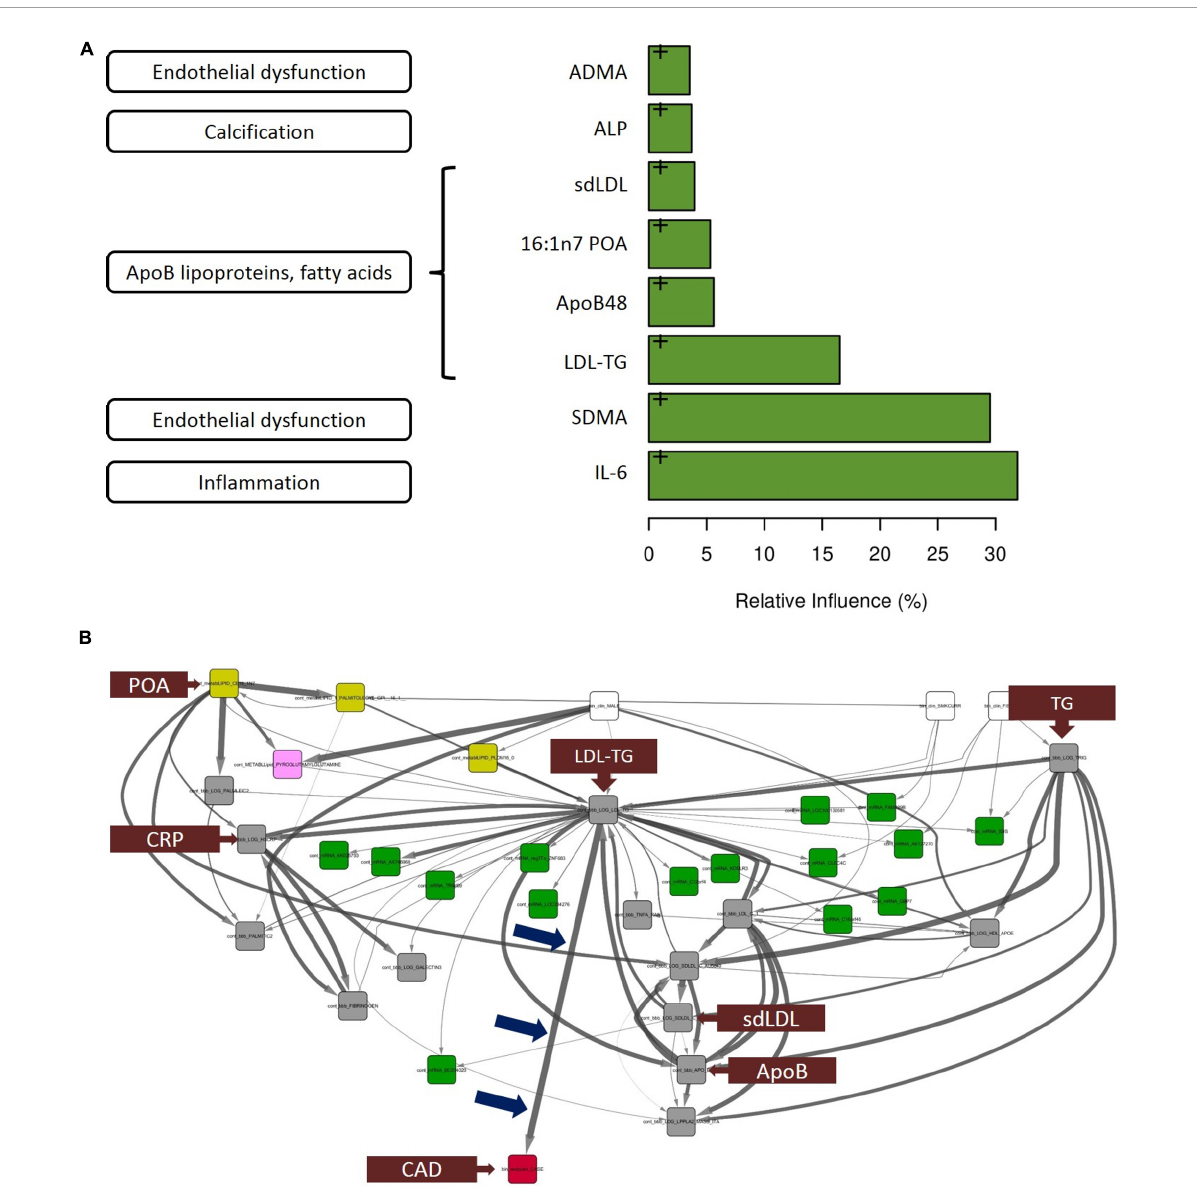
FIGURE2 Gradient boosting analysis identified the strongest predictors of atherosclerotic coronary artery disease. Hypothesis-free Bayesian network analysis using reverse engineering with forward simulation (REFS TM ) Suggests a potential causal role of triglyceride-rich LDL particles, as measured by LDL-TG levels, in the development and progression of atherosclerosis. (A) Out of the 30 conventional biomarkers included in the multivariate analysis, the top 8 analytes are shown in the bar graph. The length of the bar corresponds to the relative influence the biomarker in predicting atherosclerotic coronary artery disease. The biomarkers include IL-6 (inflammation), symmetric dimethylarginine (endothelial dysfunction), and LDL-TG (ApoB-containing lipoprotein cluster). (B) This figure is not an illustration; it is an actual output from the hypothesis-free Bayesian network analysis. A total of 24,929 nodes and 110,350 edges were discovered in more than 5% of the networks in the ensemble; shown is the subnetwork of measurements with 1 degree of separation from LDL-TG. Arrow thickness indicates the fraction of networks in which the causal edge appears; different colored boxes represent different types of measurements (yellow: mass-spectrometry–based lipidomics; pink: mass-spectrometry–based metabolomics; green: gene expression [mRNA]; gray: conventional biomarker measurements). Notably, among all of the biomarkers that were measured and included in the model, LDL-TG was the only biomarker with a direct connection to ASCAD (see blue arrows pointing to the edge connecting LDL-TG to ASCAD). This suggests that triglyceride-rich lipoprotein particles, as measured by LDL-TG levels, may have a causal role in atherosclerosis. Interestingly, in this causal model, sd-LDL, ApoB, and C-reactive protein are downstream from LDL-TG, while palmitoleic acid and total triglyceride levels appear upstream from LDL-TG. Fibrinogen and galectin-3 are downstream from C-reactive protein. ADMA, asymmetric dimethylarginine; ALP, alkaline phosphatase; ApoB, apolipoprotein B; IL-6, interleukin-6; LDL-TG, low-density lipoprotein-triglycerides; SDMA, symmetric dimethylarginine, ASCAD, atherosclerotic coronary artery disease; CAD, coronary artery disease; CRP, C-reactive protein; POA, palmitoleic acid; sd-LDL, small, dense low-density lipoprotein; TG,